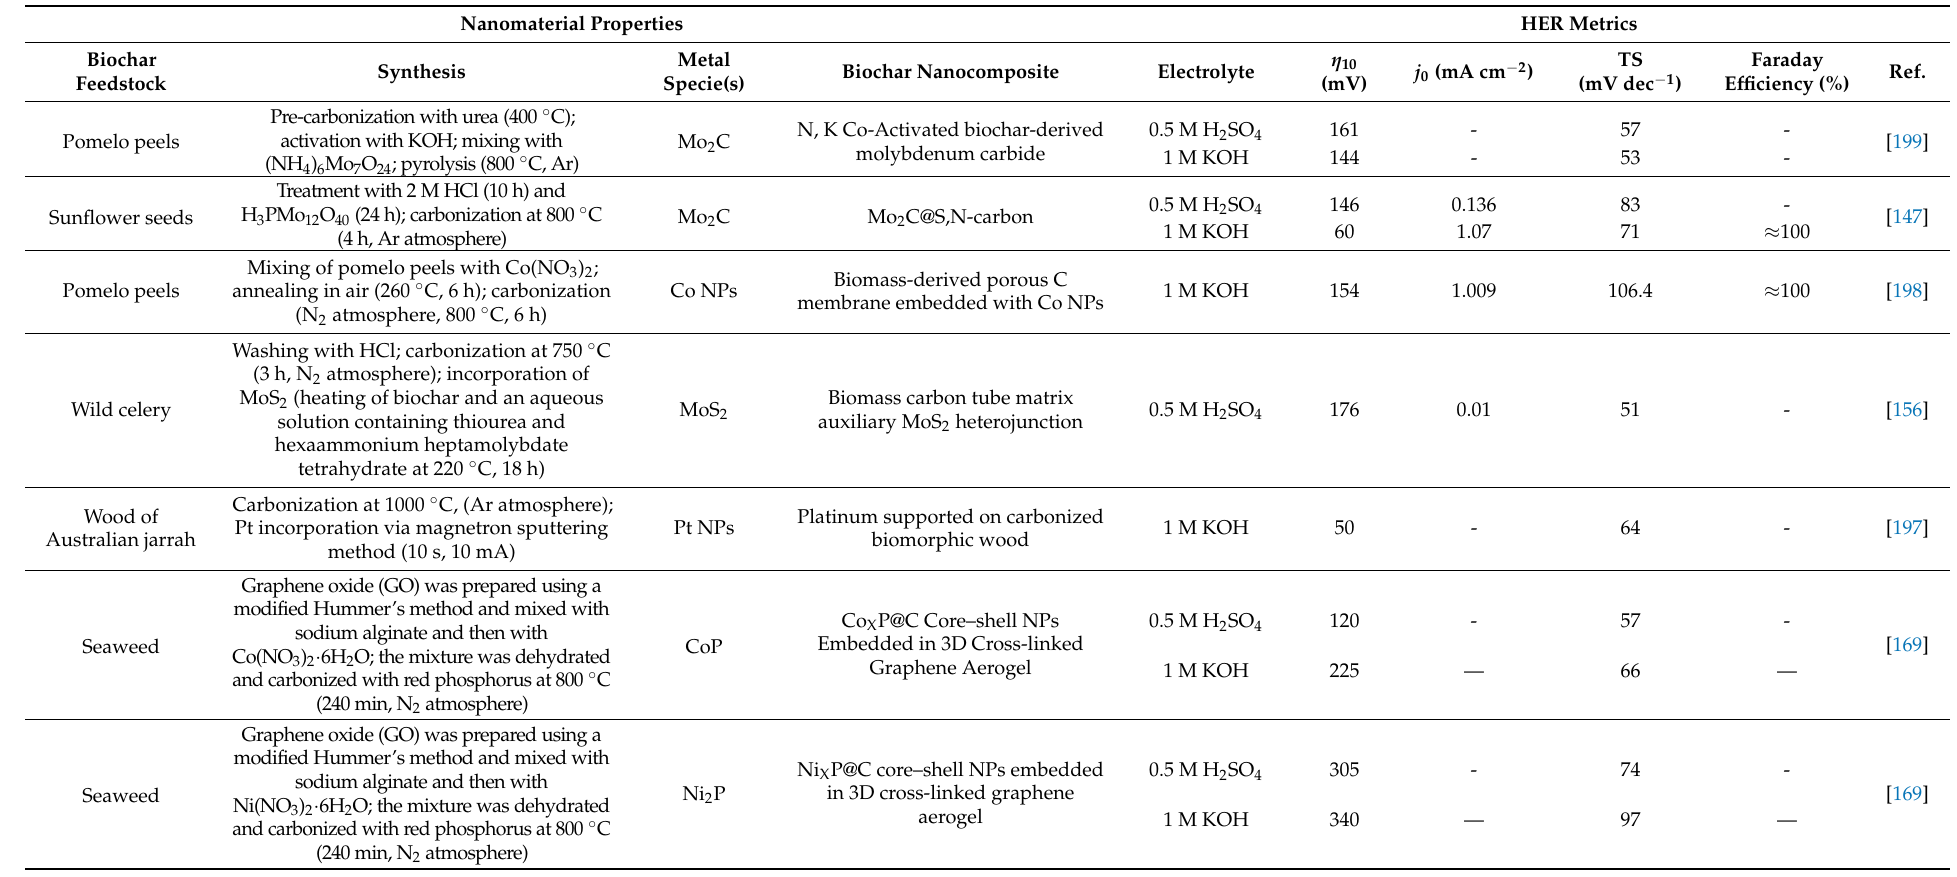
Table 8. Electrocatalytic performance of metal-supported biochar-based materials for